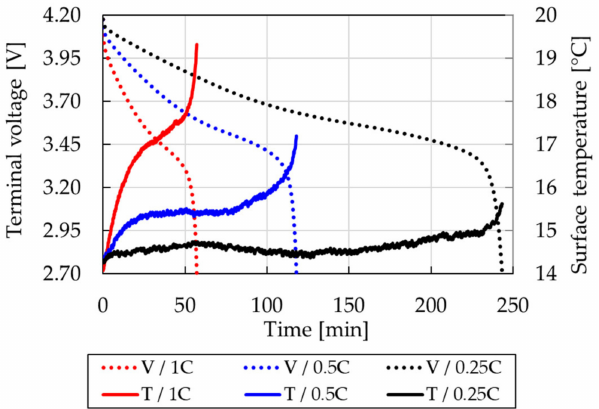
Figure 3. Temperature and voltage in time for CC discharge at various C-rates for a pristine Kokam 53 Ah